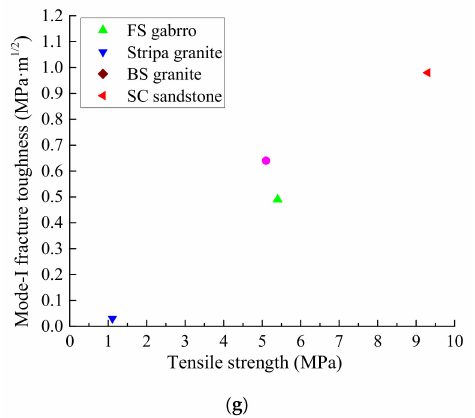
Figure 7. K IC and σ t of rock subjected to different temperatures. ( a ) 20 ◦ C; ( b ) 100 ◦ C; ( c ) 200 ◦ C; ( d ) 300 ◦ C; ( e ) 400 ◦ C; ( f ) 500 ◦ C; ( g ) 600 ◦